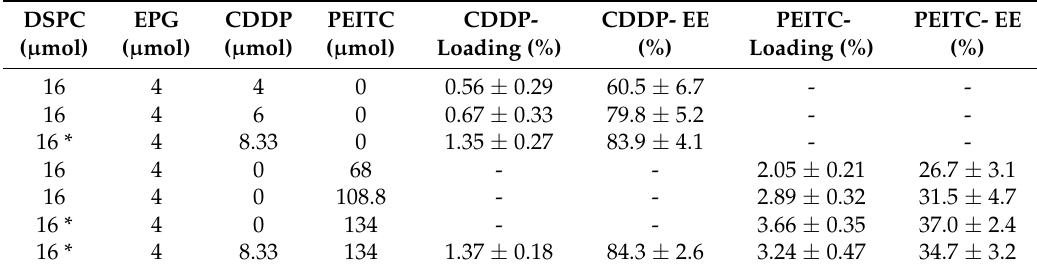
Table 1. Percent drug loading and encapsulation efficiency (EE) of cisplatin (CDDP) and/or phenethyl isothiocyanate (PEITC) in liposomes.